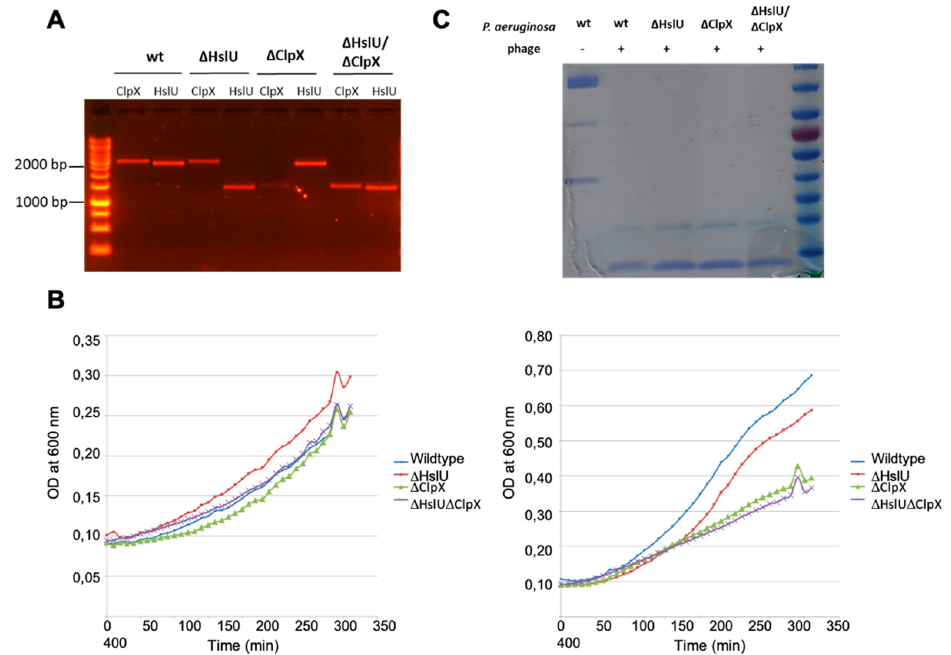
Figure A6. Rac substrate profiling. ( A ) Immunoaffinity enrichment of the Rac substrates from P. aeruginosa cell lysate. The arrow indicates the additional acetylated protein in the presence of recombinant Rac and acetyl-CoA (lane 1), compared to the control sample (lane 2). ( B ) MS analysis reveals that HslU and ClpX are present in lane 1 but not in lane 2, with sequence coverage of 24% and 7%, respectively. The identified peptide sequences are underlined.